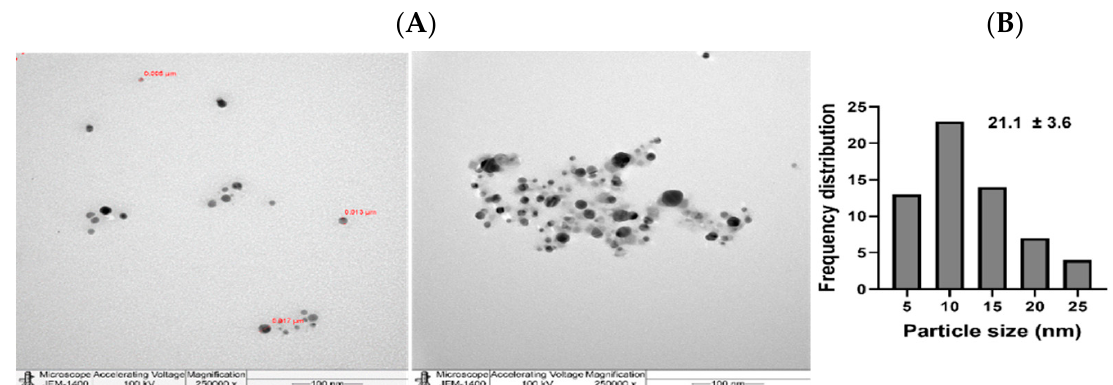
Figure 6. Spherical shape R-AgNPs ( A ) and their frequency distribution with mean particle size ( B ). Size measurements were analyzed by ImageJ software constructed from TEM micrographs at scale bars: 100 nm.